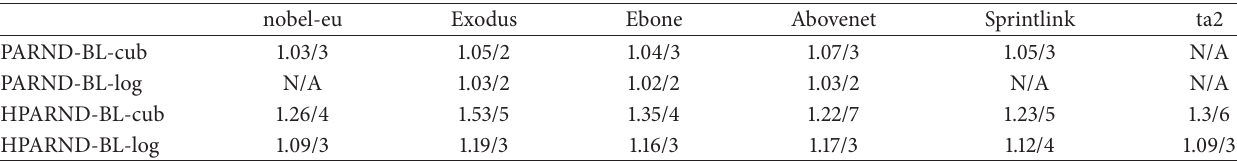
Table 13: Number of paths per flow (Avg/Max)— 𝑃 𝐶 V = 4 kW. nobel-eu Exodus Ebone Abovenet